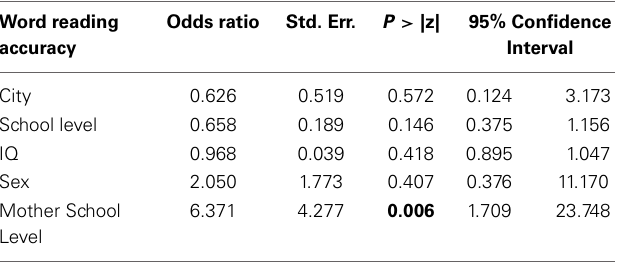
Table 7 | Logistic regressions.